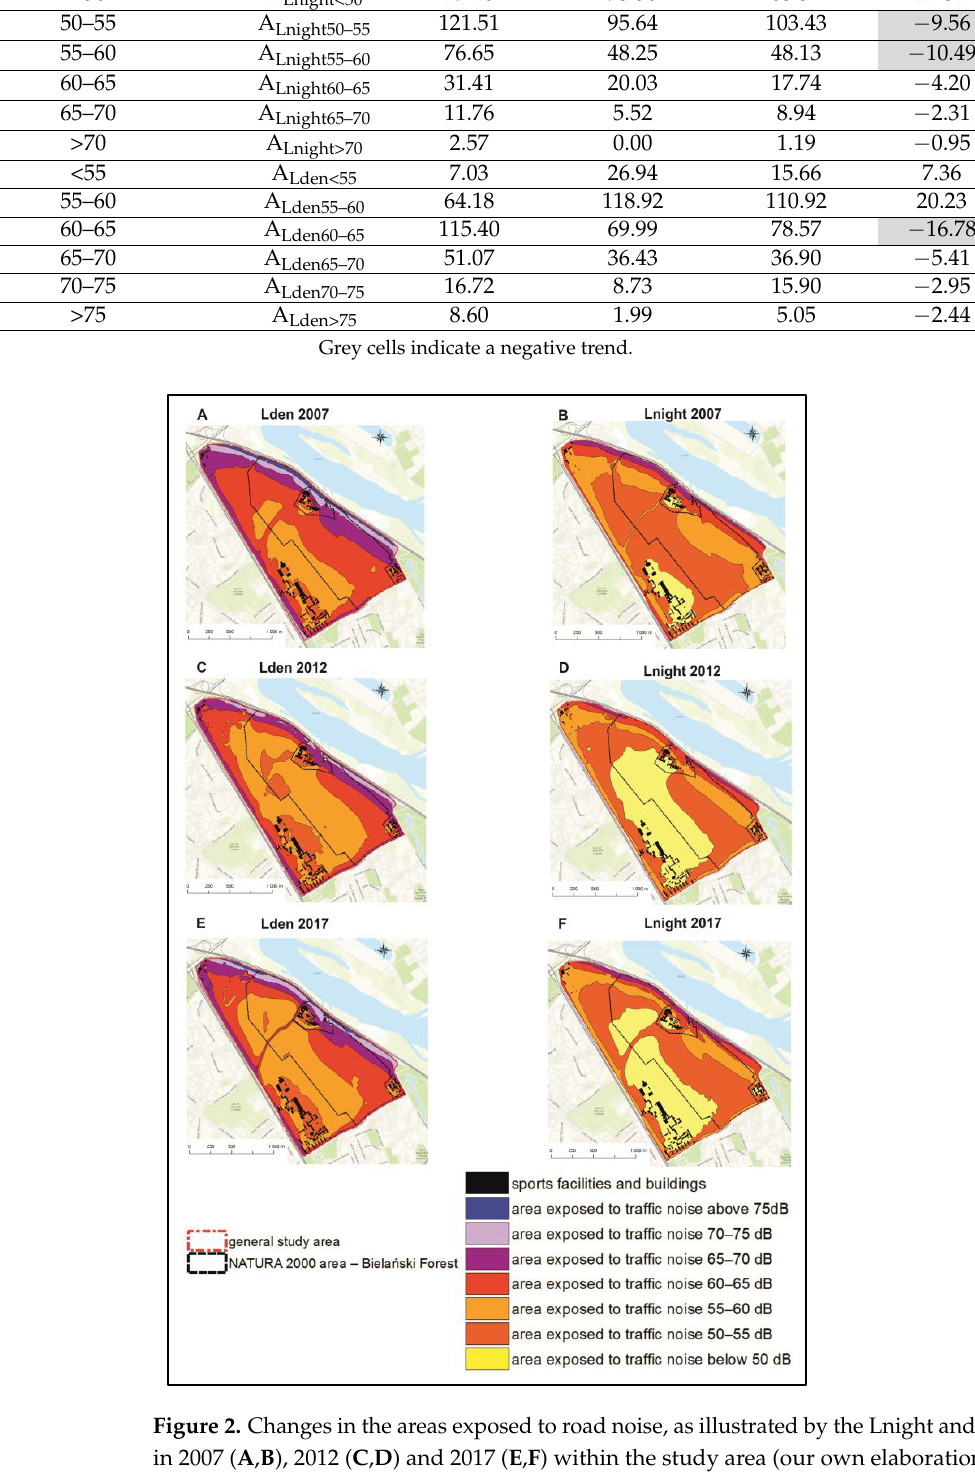
Table 1. Changes in the areas exposed to road noise according to the Lnight and Lden indicators in 2007, 2012 and 2017 within Biela´nski Forest (our own elaboration on the basis of maps of noise pollution in Warsaw). Range of Noise Levels Indicator